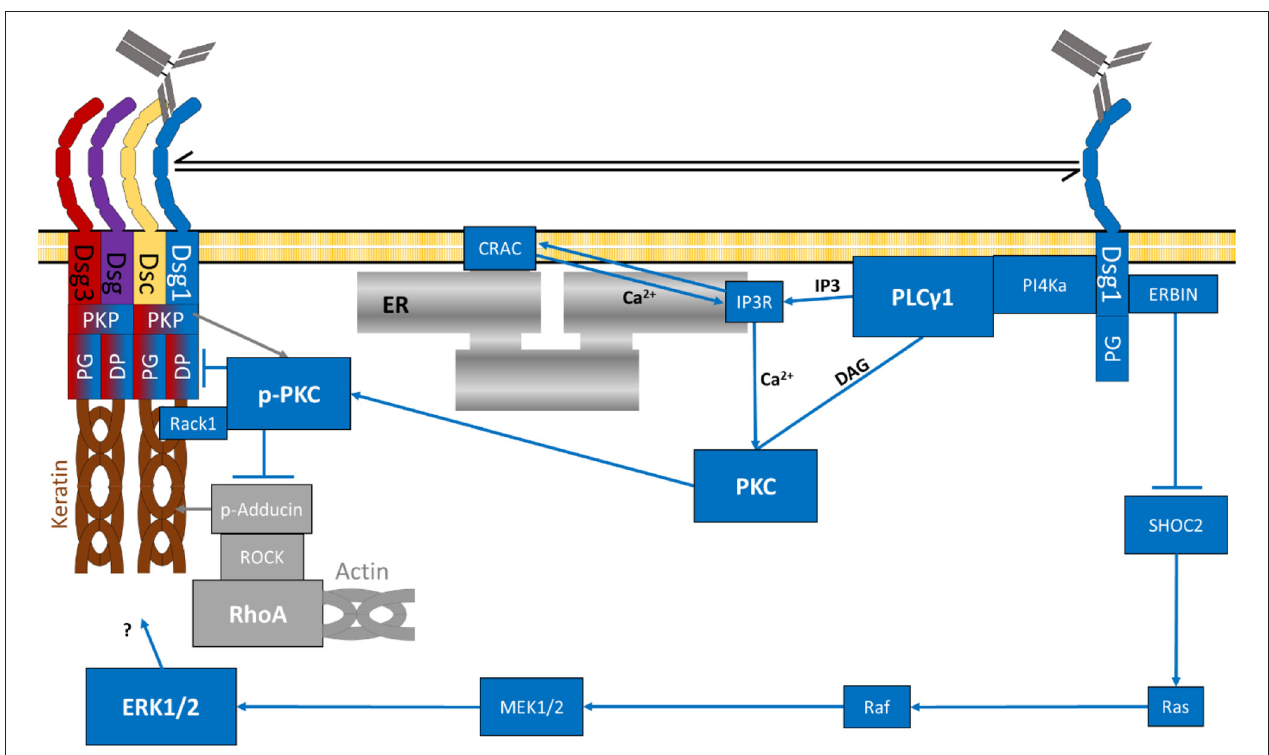
FIGURE 4 | Schematic depiction of specifically Dsg1-dependent signalling mechanisms (grey RhoA complex represents a potential rescue pathway). The specific target of Erk1/2-Elk1 is not